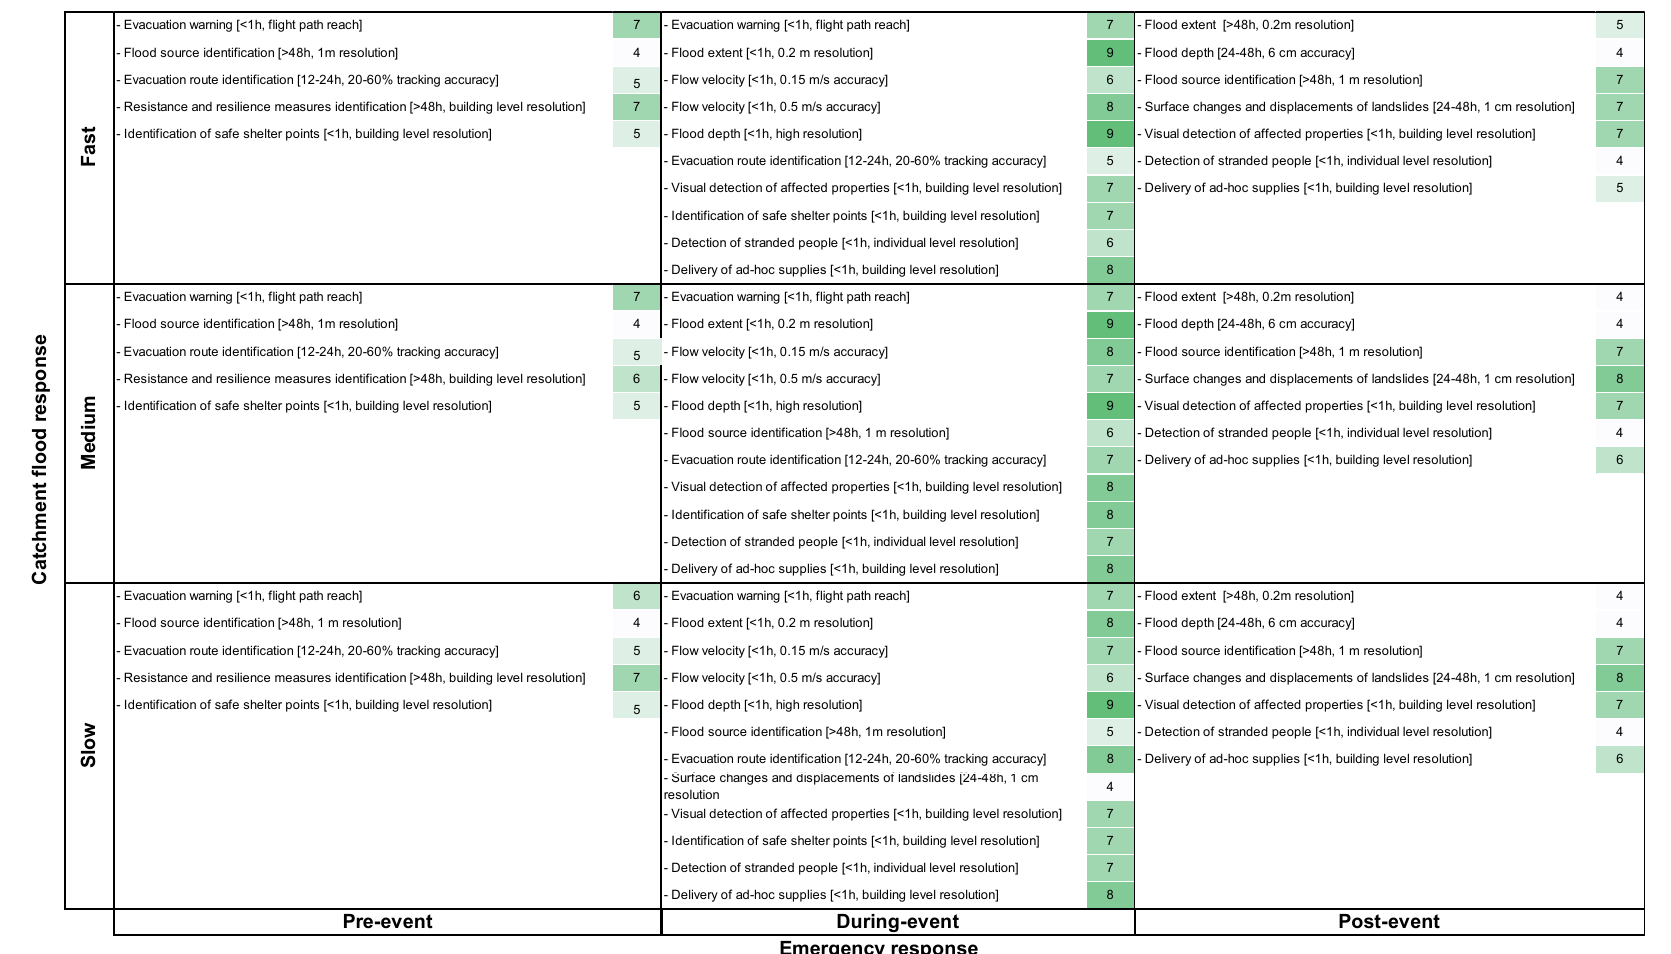
Figure 4. Respondents’ preferences in England for each UAS application in relation to catchment response and UAS deployment at different emergency response phases (before, during, post). The numbers indicate the number of participants. There were 10 participants, and therefore the maximum score possible is 10. Only UAS applications with a score ≥ 4 are shown as a means of indicating the majority opinion.